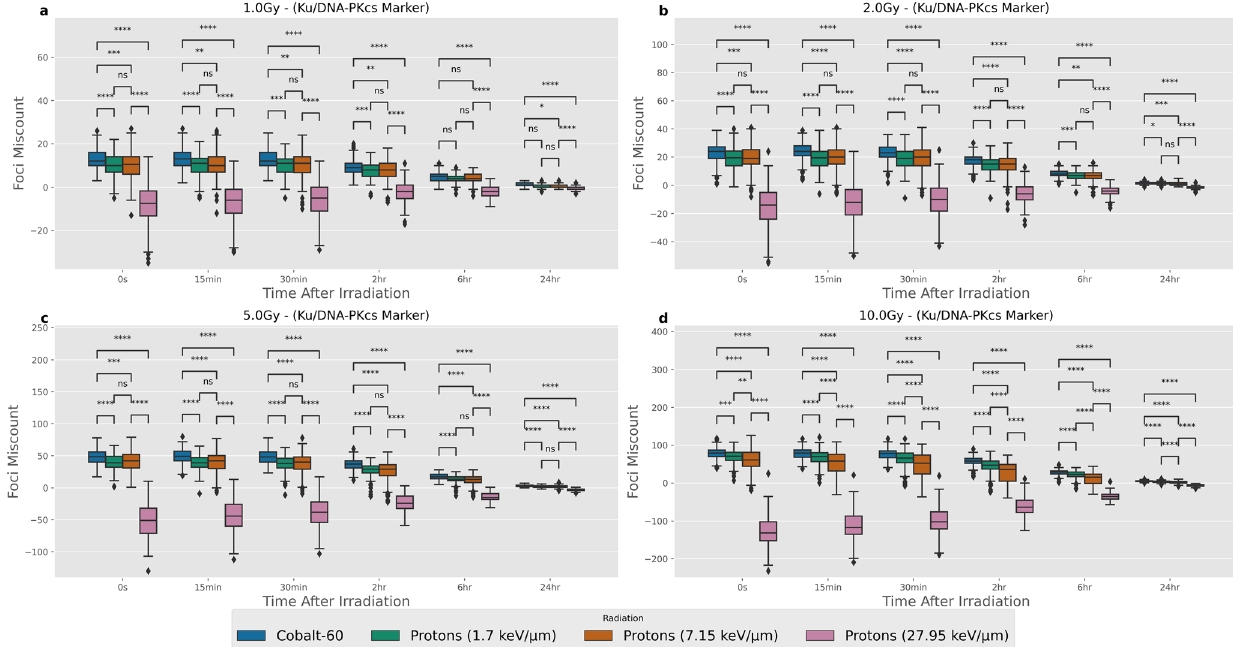
Fig. 1 Distributions of miscounting between foci detected and the number of DSBs within the central microscope slice of the cell nucleus when using a Ku/DNA-PKcs marker of fl uorescence. Each panel is the same four radiation types and six-time points being compared for different radiation doses, where a – d correspond to 1.0, 2.0, 5.0, 10.0 Gy respectively. Error bars correspond to 1.5 times the interquartile range in either direction. Mann – Whitney test between different radiation types at each time point and dose to highlight statistically signi fi cant differences. p values have been adjusted using the Bonferroni correction. Signi fi cance notation refers to the following thresholds: ns = p > 0.05, * p > 0.01, ** p > 1e − 3, *** p > 1e − 4, **** p < 1e − 4. There are 200 samples for each box-plot. All microscope images have been emulated using the Airyscan ×63 point spread